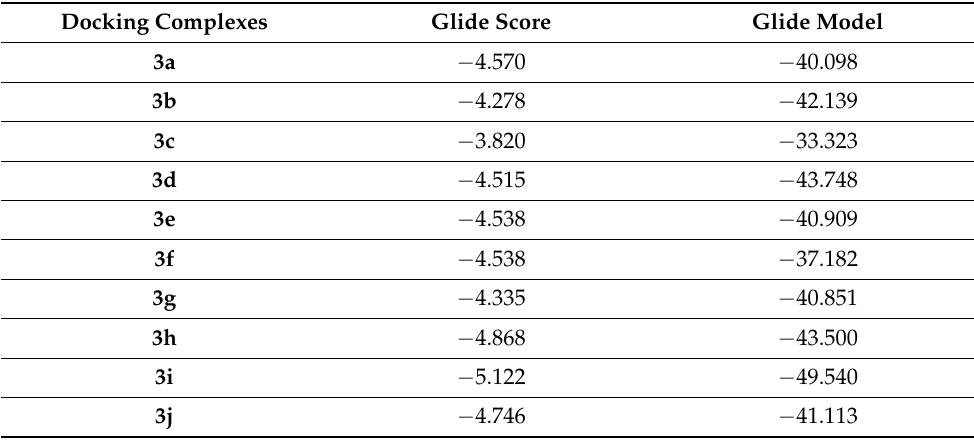
Table 4. Glide energy score of docked